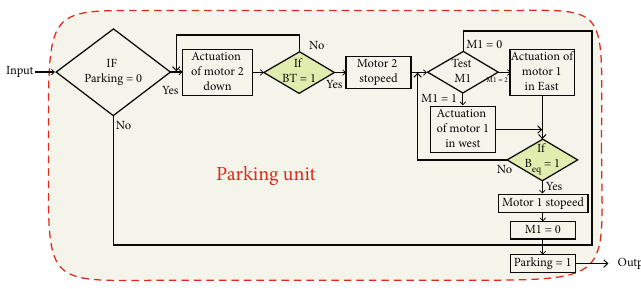
Figure 41: The fl owchart of the parking unit.